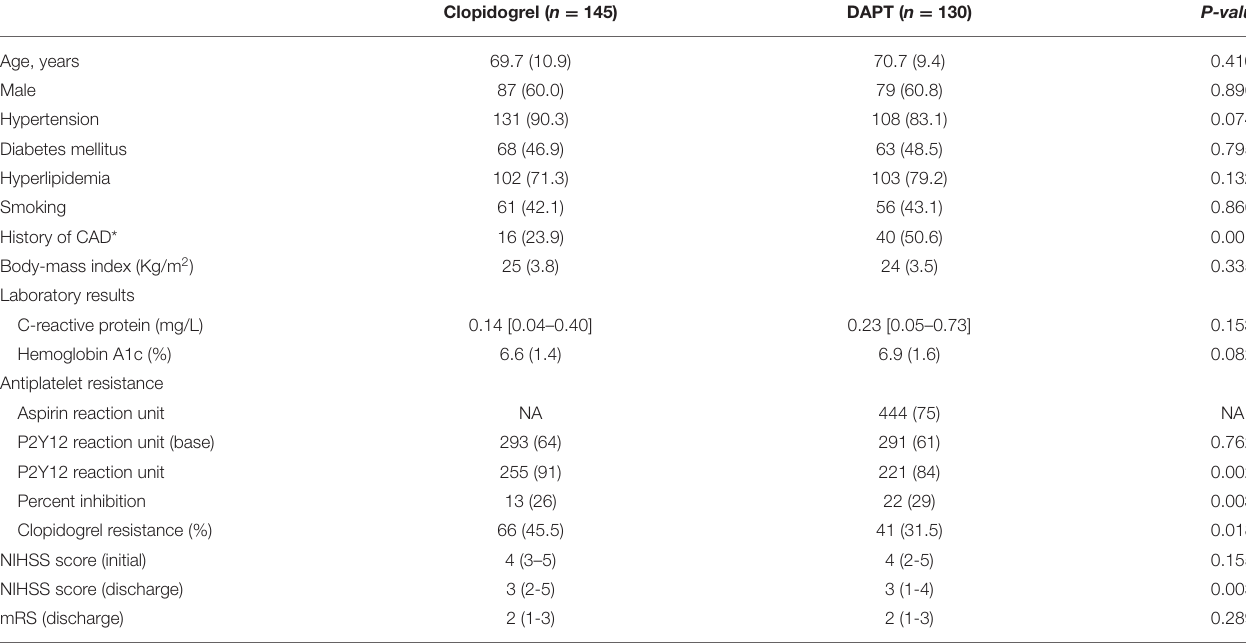
TABLE 1 | Clinical characteristics and HPR stratified by antiplatelet treatment for stroke